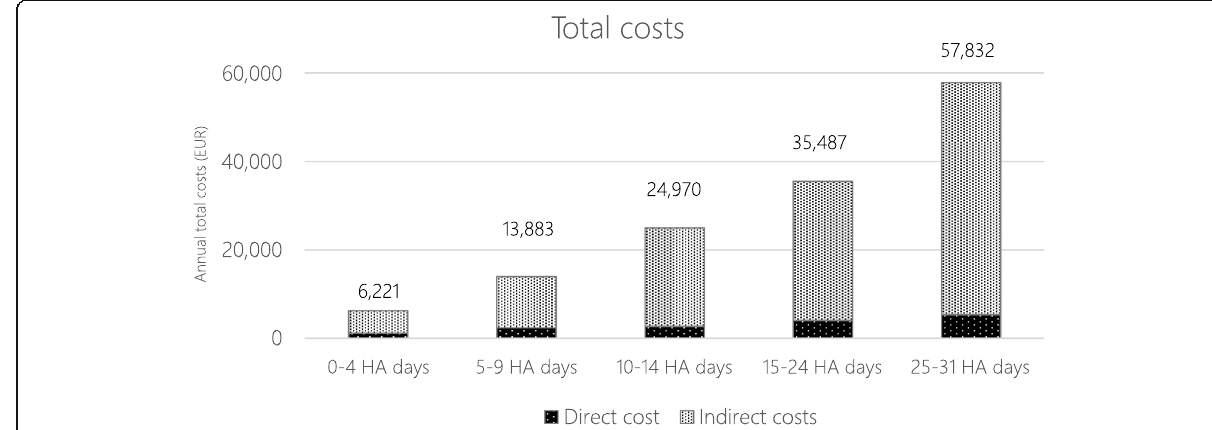
Fig. 4 Annual total costs per headache days. Key: HA, headache